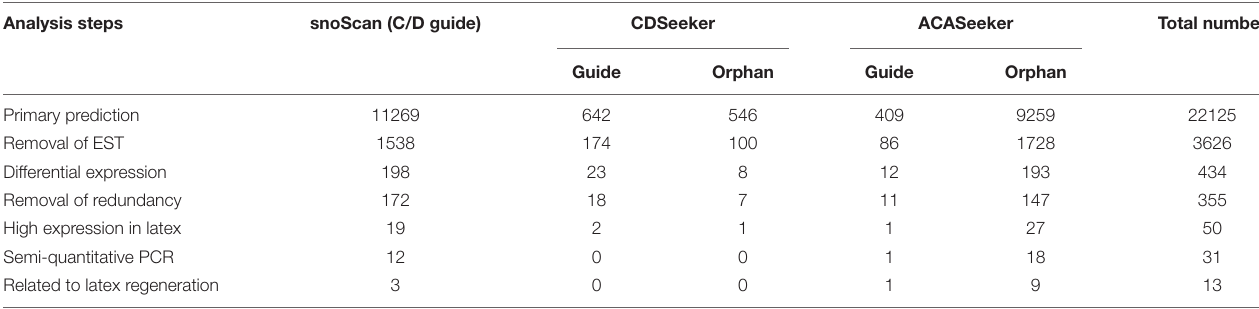
TABLE 2 | Statistics of identification of latex-abundant small nucleolar RNAs (snoRNAs) in Hevea brasiliensis. Analysis